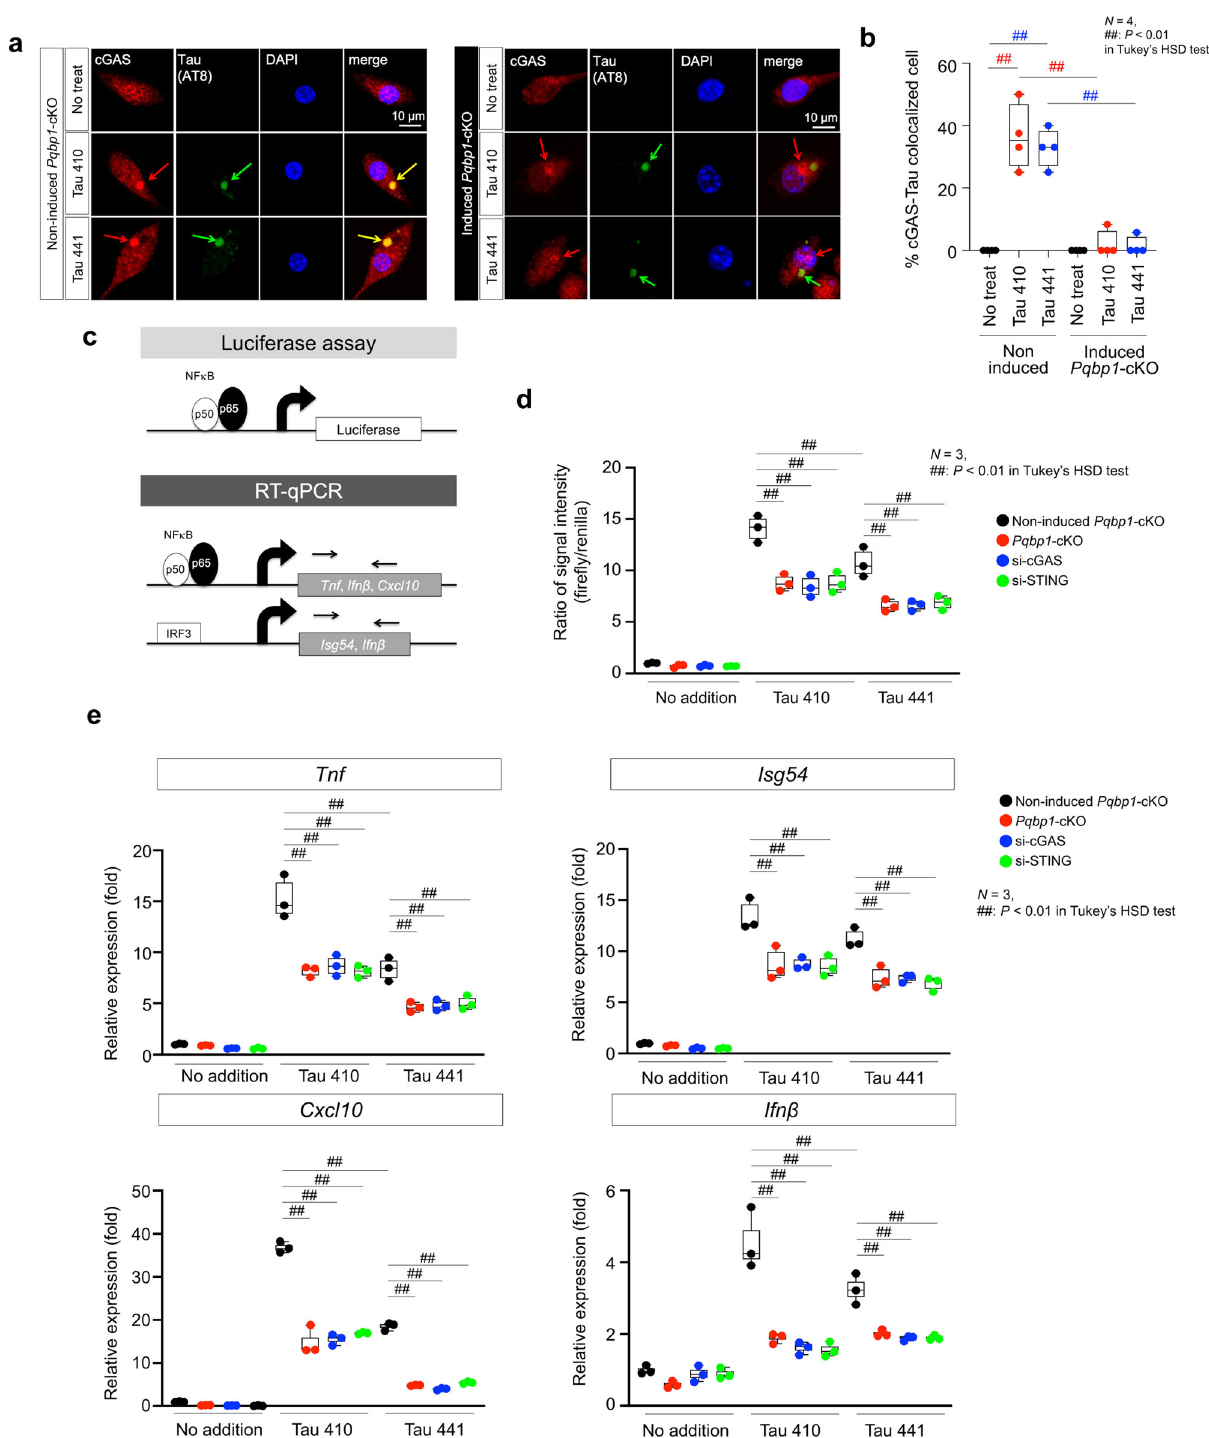
fl uorescent protein (RFP) or luciferase driven by NF κ B promoter (Fig. 8b). NF κ B activation in microglia by addition of Tau 410 to the culture medium was suppressed by Lrp1 -KO or Trem2 -KO in the RFP signal assay, as expected (Fig. 8c). In the case of additional Pqbp1 -cKO by tamoxifen, NF κ B activity was unchanged in Lrp1 -KO microglia, but further suppressed in Trem2 -KO (Fig. 8c). The discrepancy between NF κ B activities in Lrp1 -KO and Trem2 -KO cells under the additional Pqbp1 -cKO was also con fi rmed by luciferase assay (Fig. 8d). These genetic